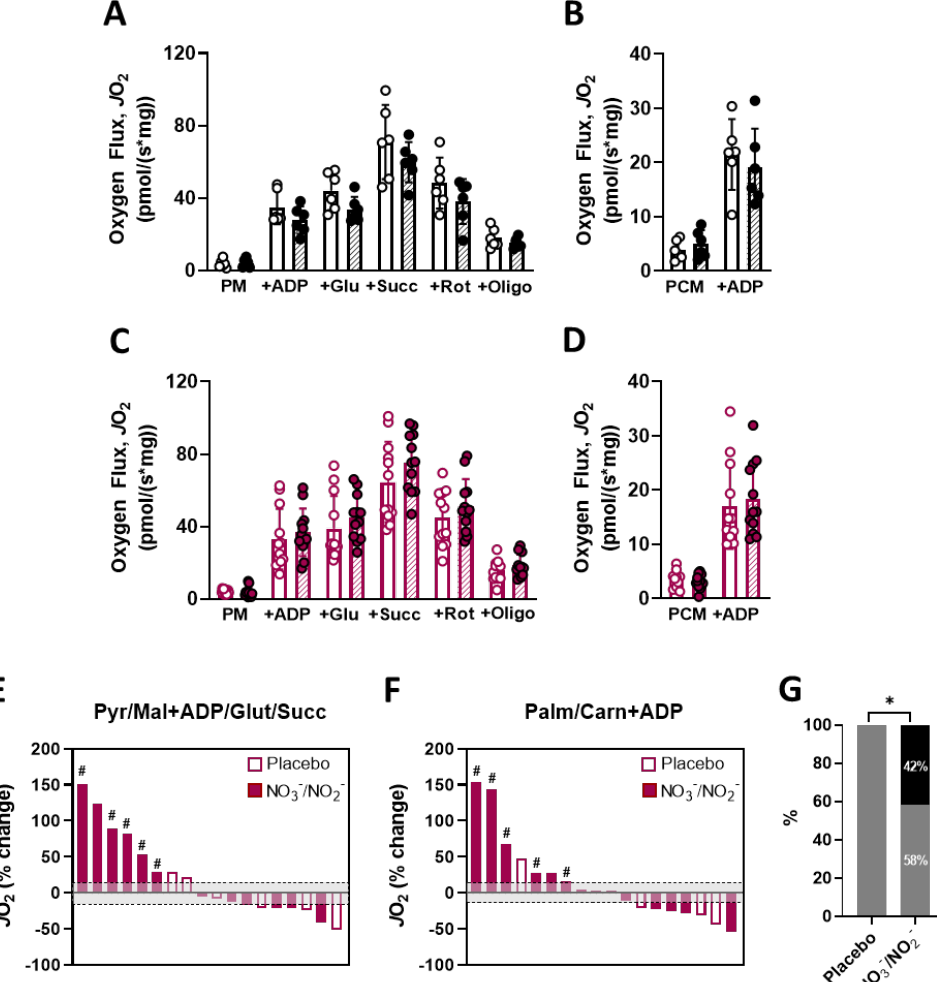
Figure 5. Mitochondrial respiratory capacity in skeletal muscle of T2DM after combined NO 3 − /NO 2 − supplementation. ( A ) Quantification of carbohydrate (CHO)-supported mitochondrial respiration in permeabilized muscle fibers of T2DM in the placebo group (N = 6). ( B ) FA-supported mitochon- drial respiration in the same conditions as described in A. ( C ) Quantification of CHO-supported mitochondrial respiration in permeabilized muscle fibers of T2DM in the NO 3 − /NO 2 − group (N = 12). ( D ) Fatty Acid (FA)-supported mitochondrial respiration in the same conditions as described in C. ( E ) Waterfall plot denoting individual % changes in CHO-supported mitochondrial respiration after intervention in both placebo and NO 3 − /NO 2 − groups. Shaded area represents CV of high resolution respirometry in permeabilized human muscle fibers [37]. ( F ) Waterfall plot denoting individual % changes in FA-supported mitochondrial respiration as described in E. ( G ) Percentage of individuals that presented increases in both CHO-supported and FA-supported respiration (black section of columns) vs. others (grey section of columns). Data are presented as mean ± SD for A, B, C and D. Common subjects in Figure 5E,F (i.e., highly responsive to the supplementation in terms of mito- chondrial respiration) are denoted by “#”. * p < 0.05.